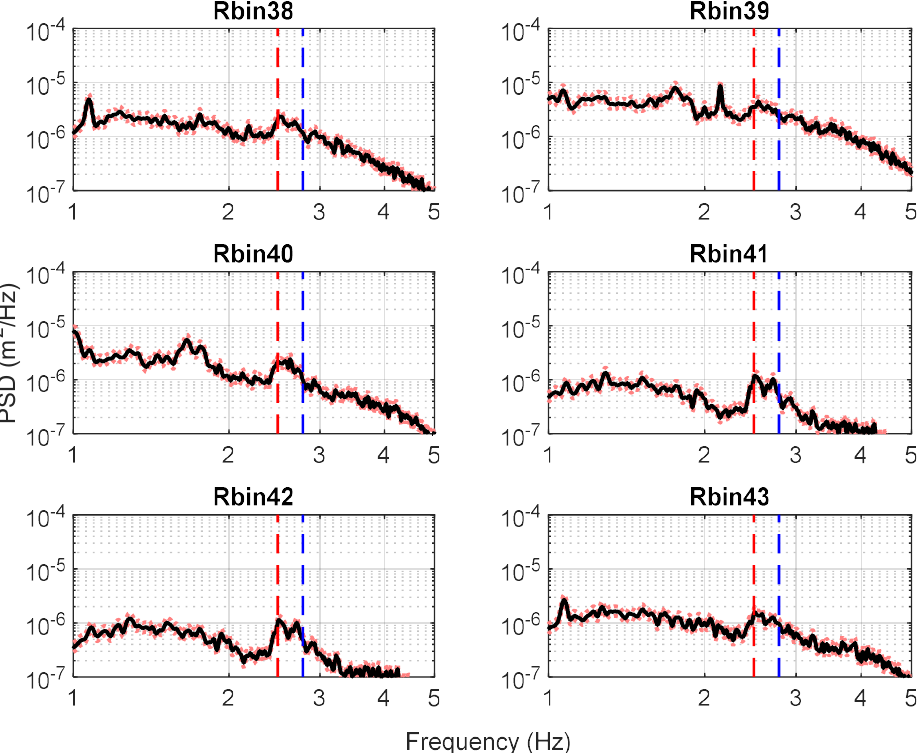
Figure 11. PSDs calculated by the Welch method for the signals recorded from Rbin38 to Rbin43. The dashed lines indicate the frequencies 2.49 Hz ( red ) and 2.79 Hz ( blue ), identified with the accelerometric